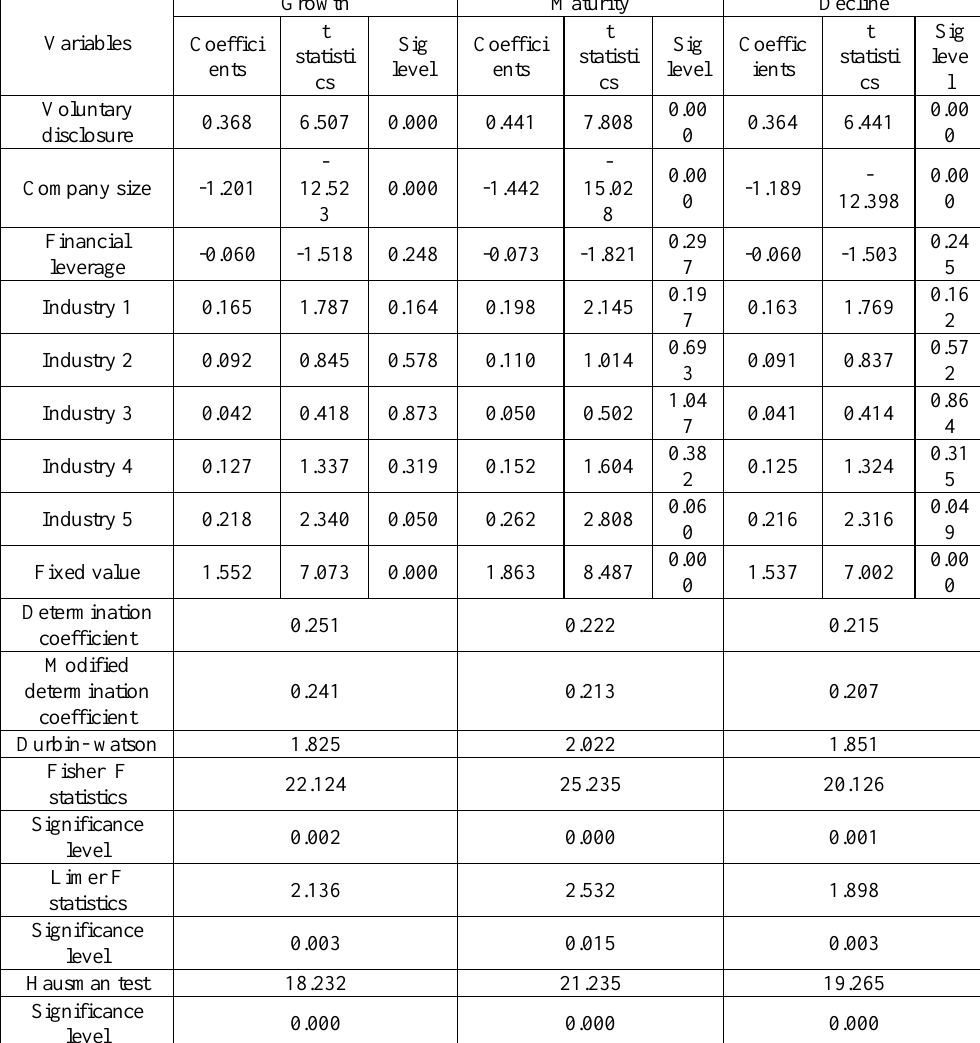
Table 6. Results of testing the relationship between voluntary disclosure and Tobin Q ratio